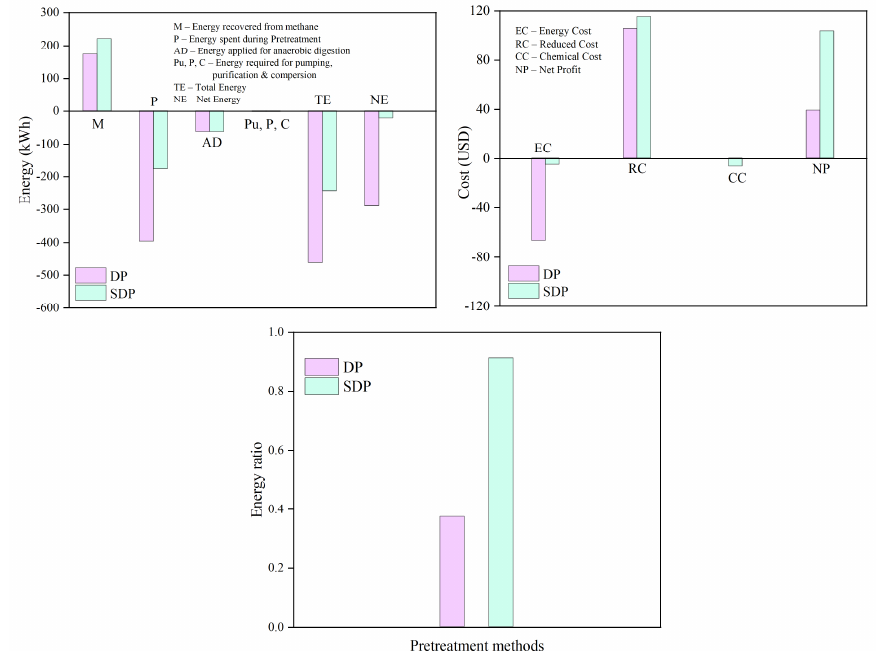
Figure 8. Energy and cost analysis for DP and SDP processes.